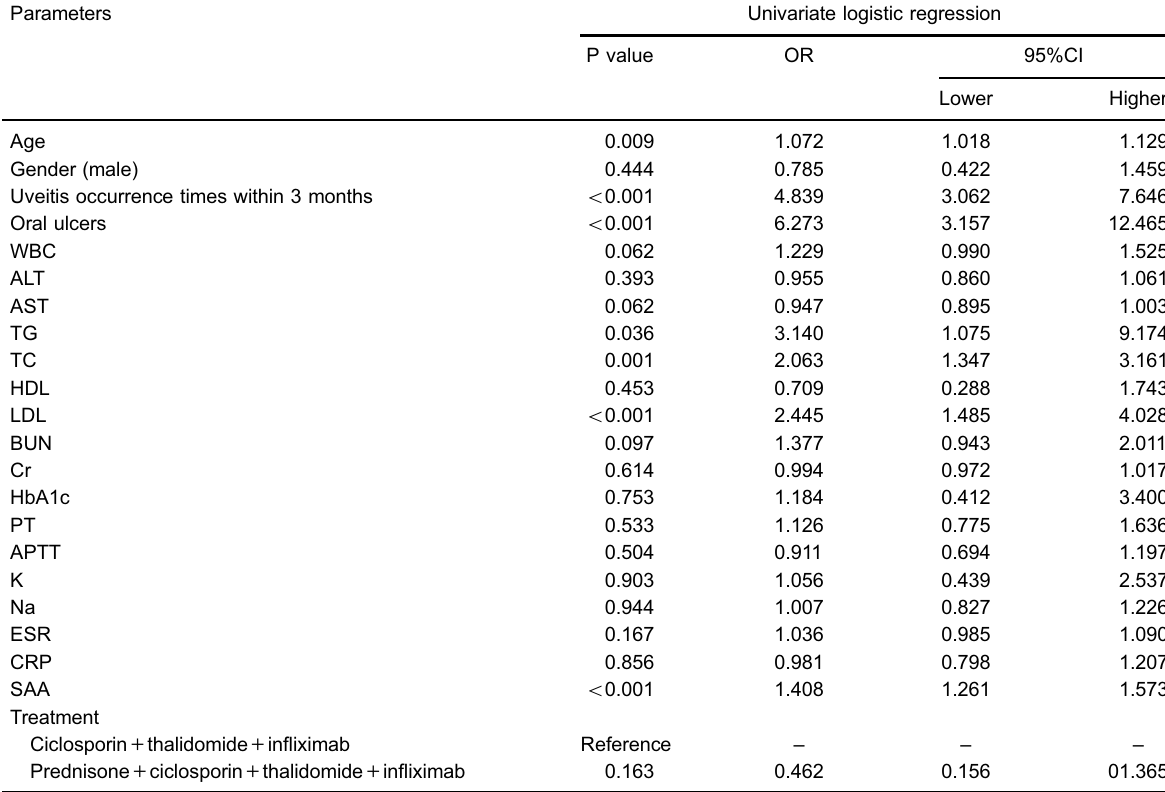
Table 2. Univariate logistic regression analysis of factors affecting anterior uveitis recurrence.